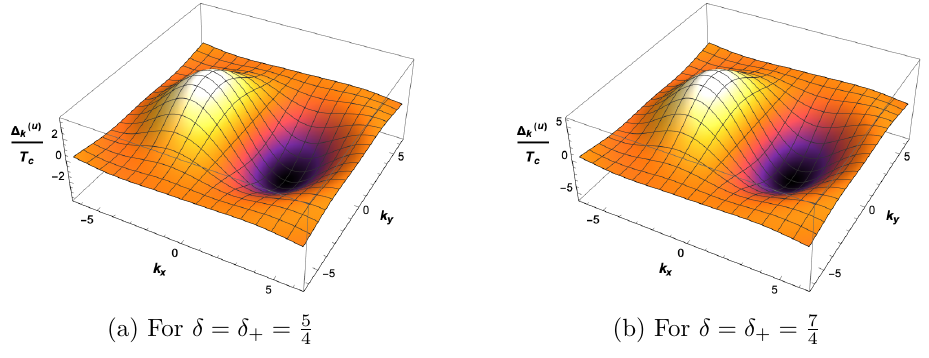
Figure 2. The p -wave gap function (order parameter) for m 2 = − 3